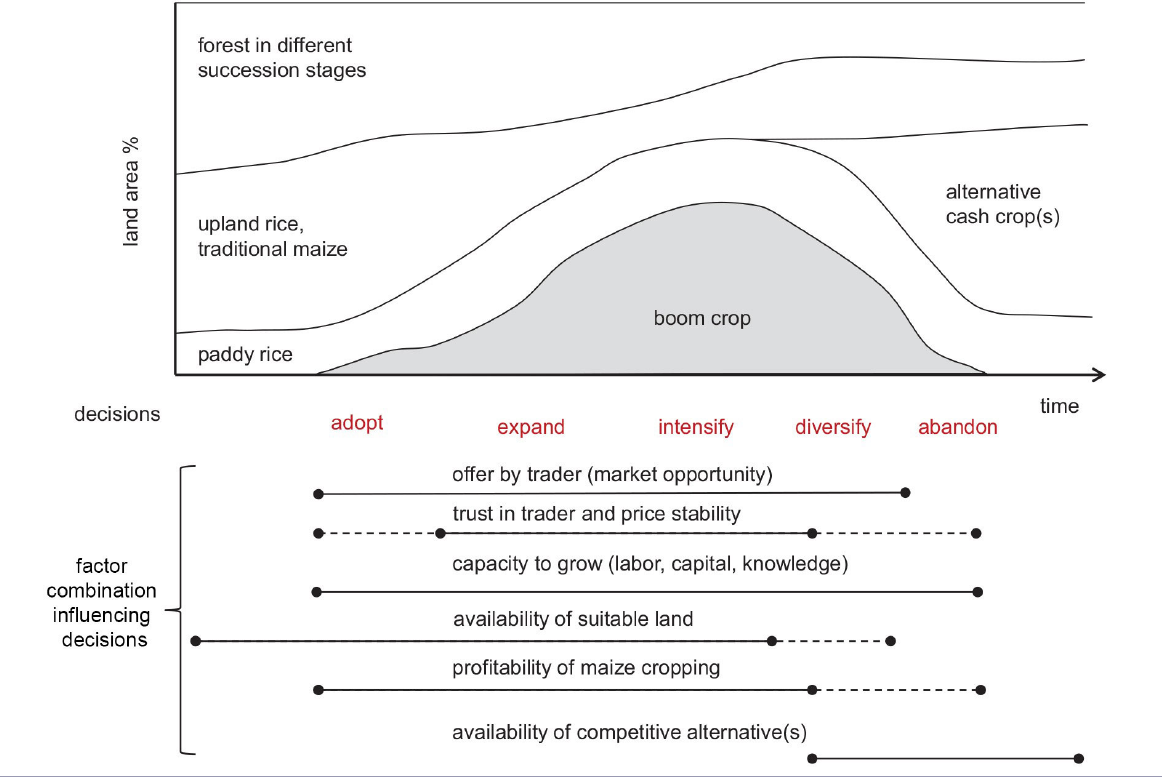
Fig. 4 . Factor combinations that build the context for farmer’s decisions in the maize boom and bust. This is the narrative/conceptual model underlying the metagame mahasaly. Solid line = factor present; dashed line = factor may or may not be present